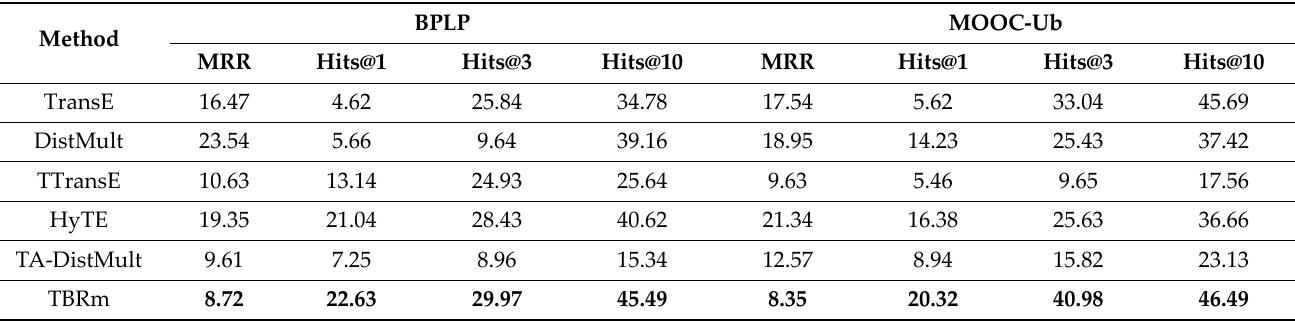
Table 3. Results (percentages) on the BPLP and MOOC‑Ub datasets.